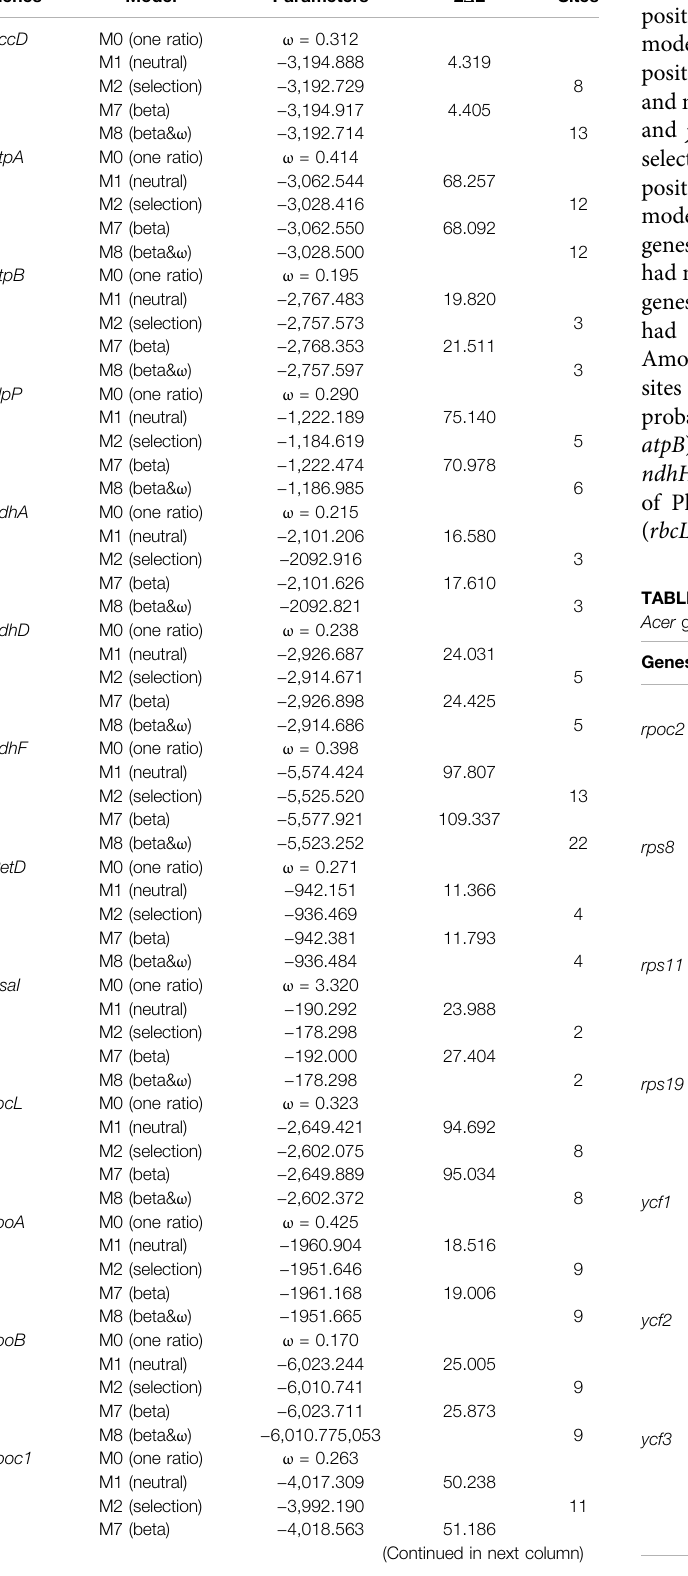
TABLE 3| Detection ofpositiveselectionsites ofchloroplastgenesin Acer genus. Genes